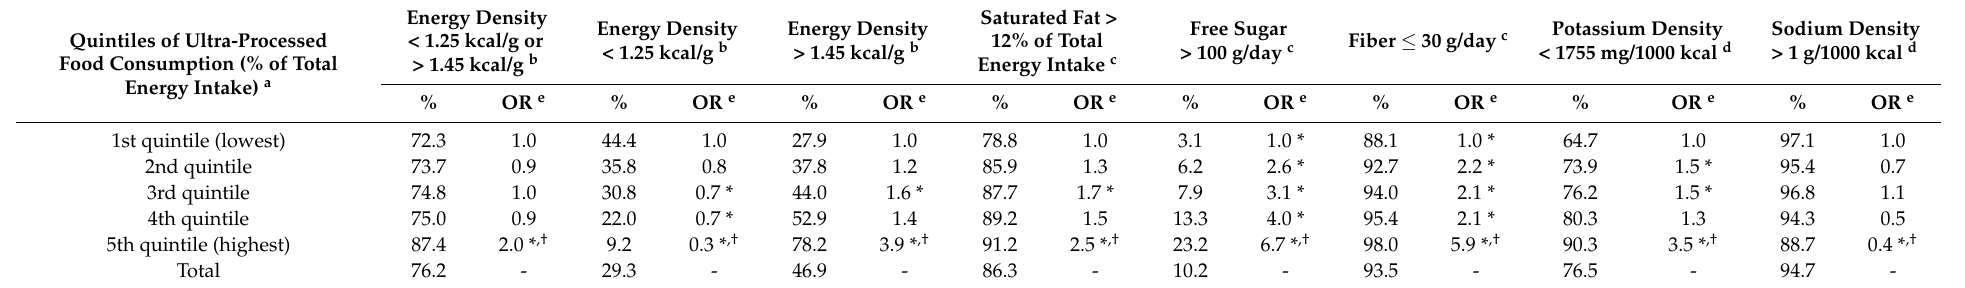
Table 6. Prevalence of inadequate nutrient intake across overall population and according to quintiles of ultra-processed food consumption. French population aged ≥ 18 years old. ENNS 2006 ( n =